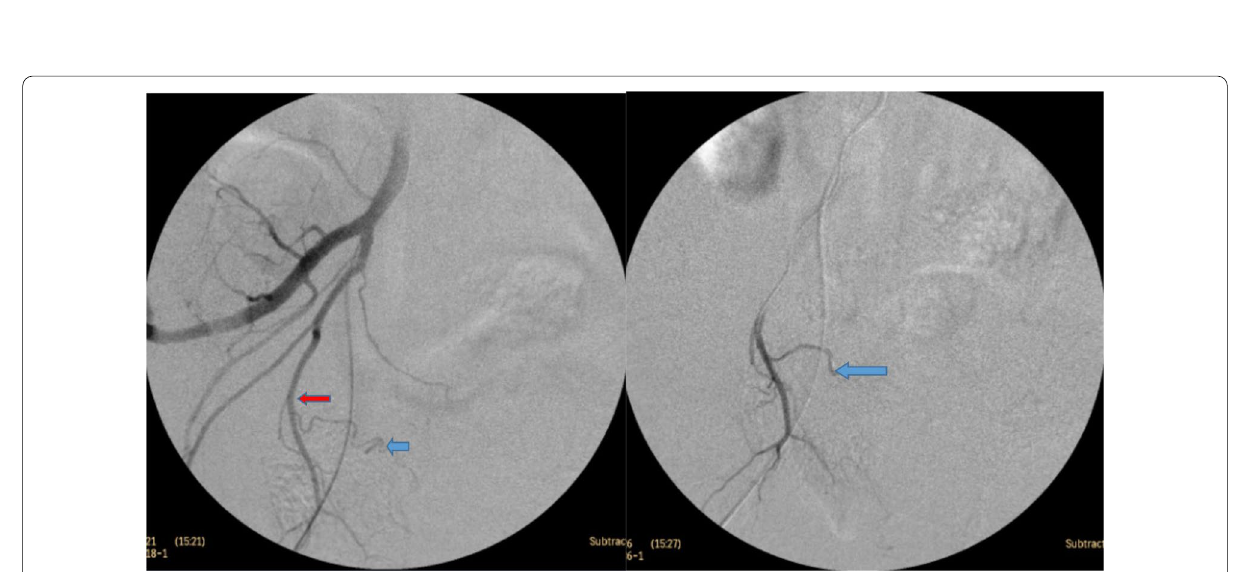
Fig. 4 Angiography images showing the prostatic artery (blue arrow) arising from the right obturator artery (red